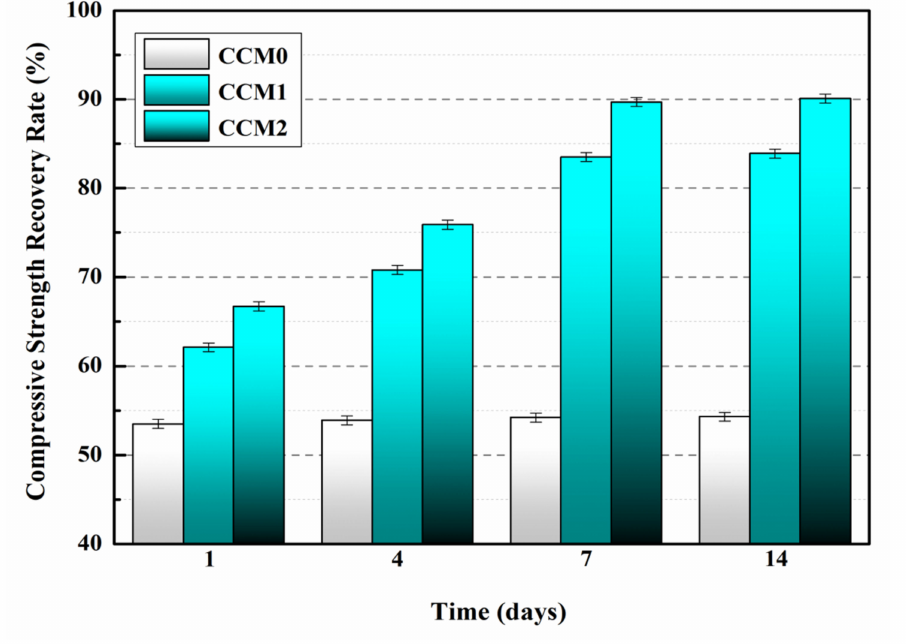
Figure 8. Compressive strength recovery rates of mortars.